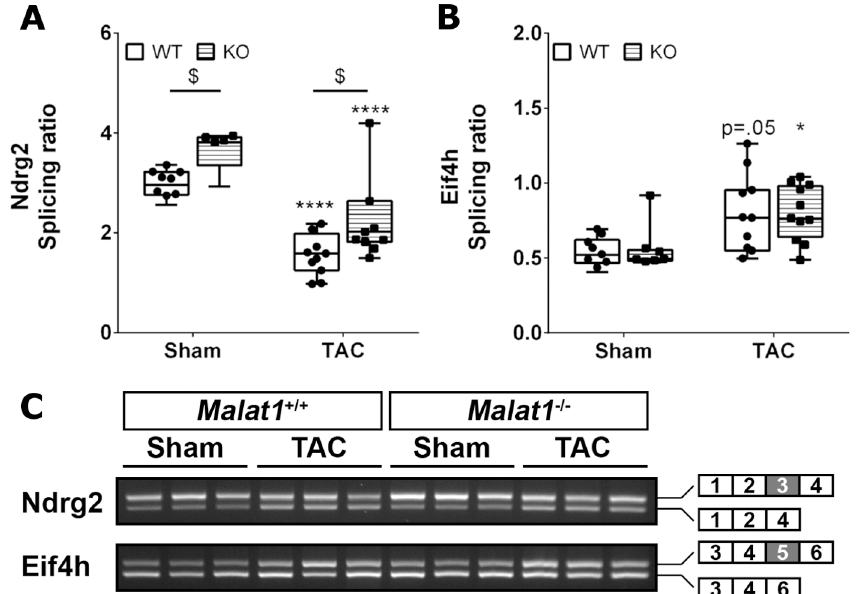
Fig 4. Alternative splicing of Ndrg2 and Eif4h is evident after TAC. (A) Skipping of Ndrg2 exon 3 is apparent after TAC in Malat-1 WT and KO mice, but absence of Malat-1 reduces this event both at baseline and after pressure overload. (B) Exon 5 inclusion of Eif4h is induced by TAC but not affected by absence of Malat-1. (C) Representative images of PCR products of Eif4h and Ndrg2 . * p < 0.05, **** p < 0.0001 TAC versus Sham; $ p < 0.05 KO versus